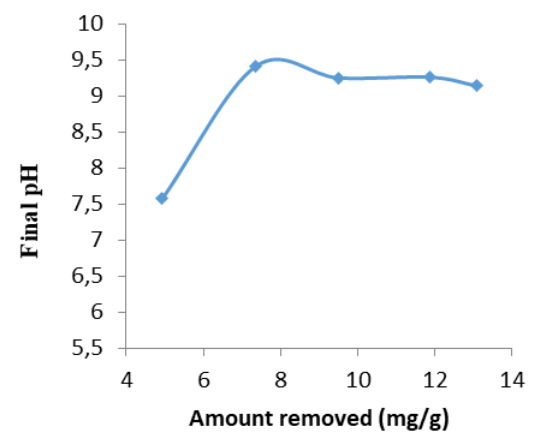
Fig. 15. Relationship between metal sorbbed amount and final pH after 20 min of Cd 2+ ions interaction with